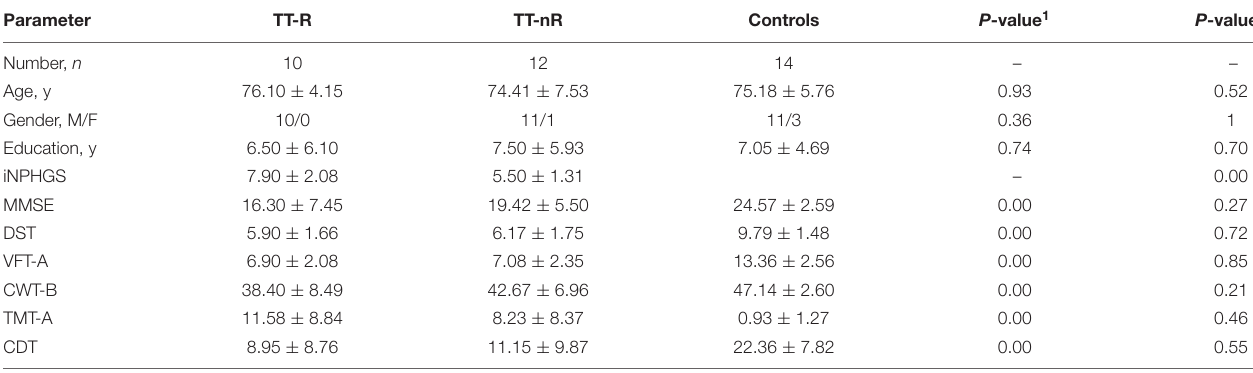
TABLE 1 | Demographic and characteristics of all subjects.